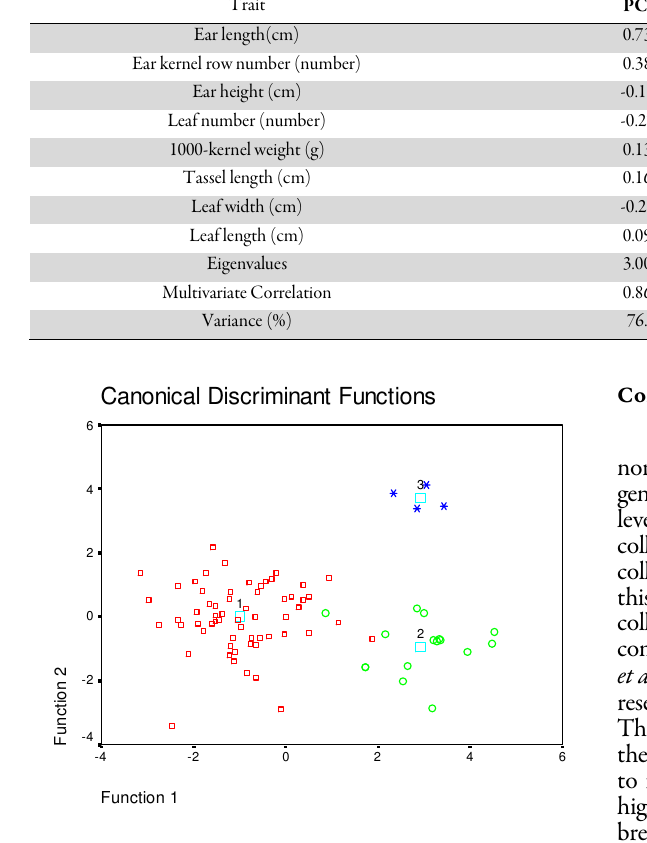
Fig. 1. The grouping of Turkish maize accessions based on multivariate discriminant function analysis for agro- morphological traits. Maize genotypes were displayed as Flint(1), Popcorn(2), and Dent